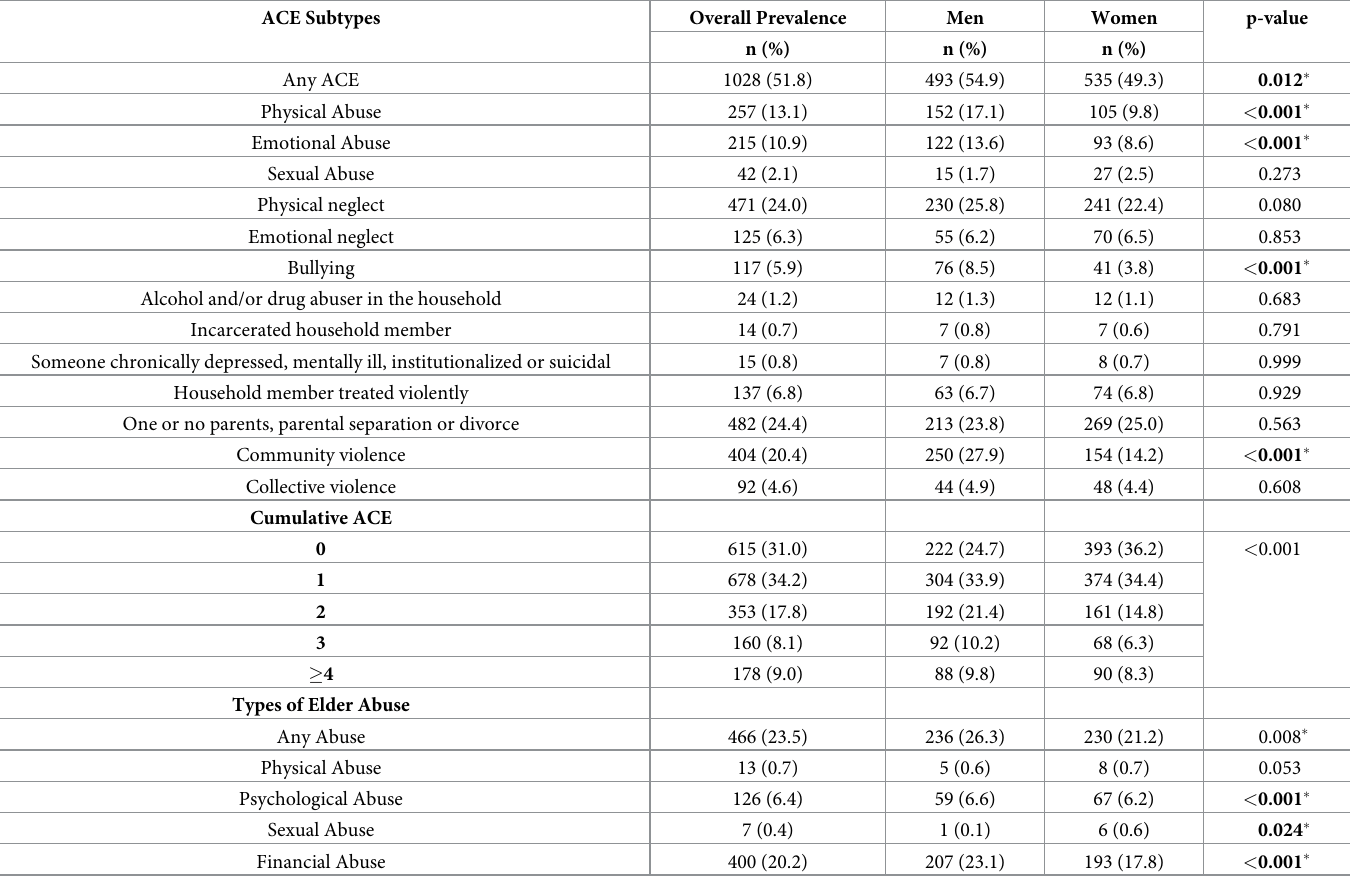
Table 2. Prevalence of ACE and elder abuse among older adults according to